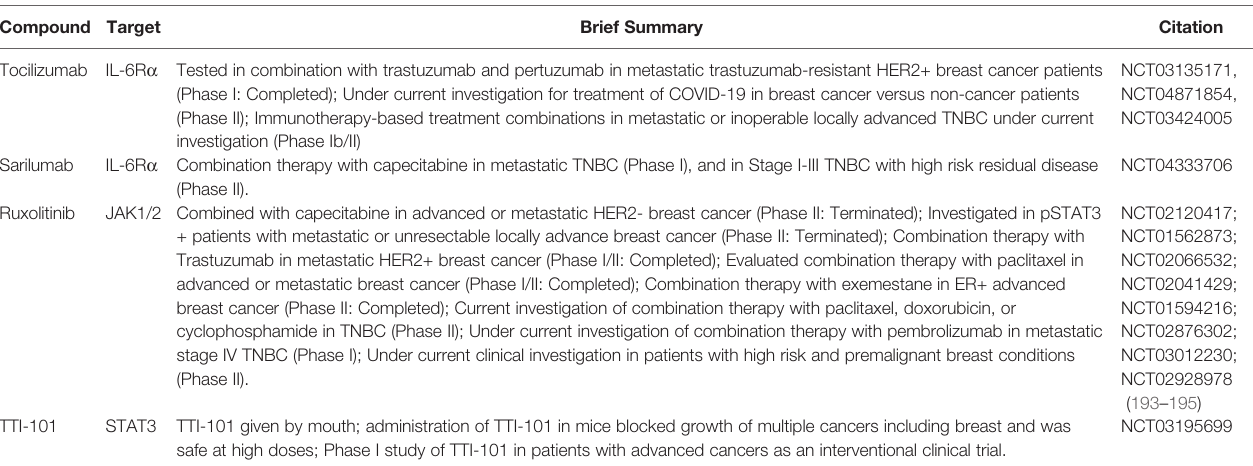
TABLE 2 | Clinical Studies Targeting IL-6/JAK/STAT3 in Breast